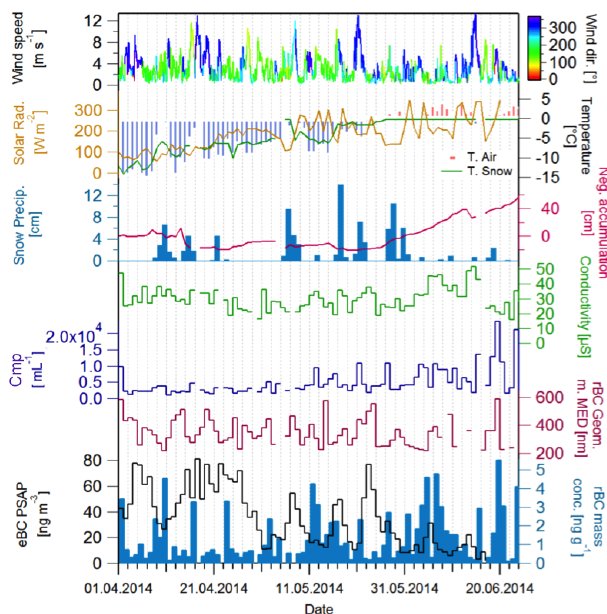
Figure 3. The 3d experiments snow samples with the hourly rBC mass concentration and smoothed line (light blue bars), atmo- spheric eBC mass concentration in the atmosphere (black), geomet- ric mean mass equivalent diameter (purple) the number concentra- tion of coarse-mode particles (Cmp – blue) and the total conductiv- ity (green). Meteo/snow parameters used in the statistical exercise are wind speed (color coded for wind direction), solar radiation (or- ange line), air and surface snow temperature (blue bars and green line, respectively) and amount of fresh snow (snow precipitation; light blue bars). The yellow bars are centered on the midnight hours for the 3 sampling